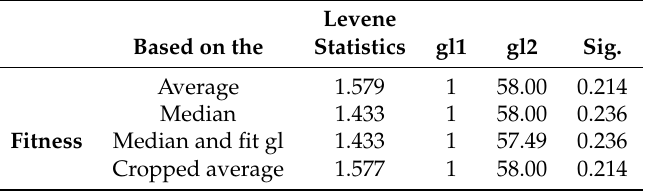
Table 6. Homogeneity test of variances.